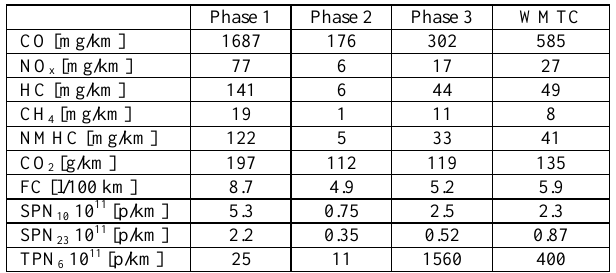
Table 2. Emission results for the WMTC and its phases. FC = fuel con- sumption; SPN = solid particle number; TPN = total particle